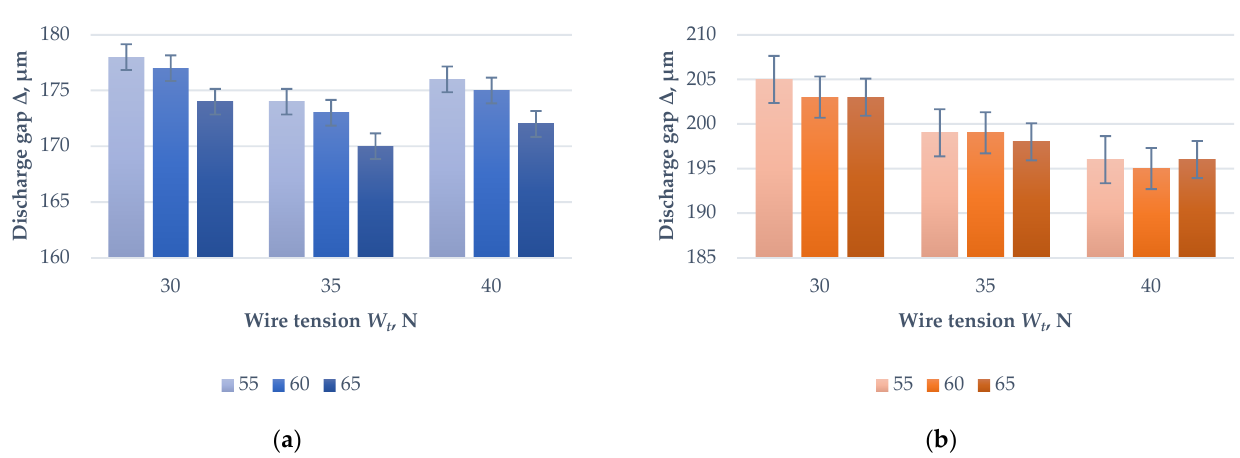
Figure 2. Histograms of the measured discharge gaps on electrical discharge machining factors V o and W t : ( a ) X10CrNiTi18- 10 (12kH18N10T) steel; ( b ) D16 (AA2024) allo2024 (D16) duralumin.